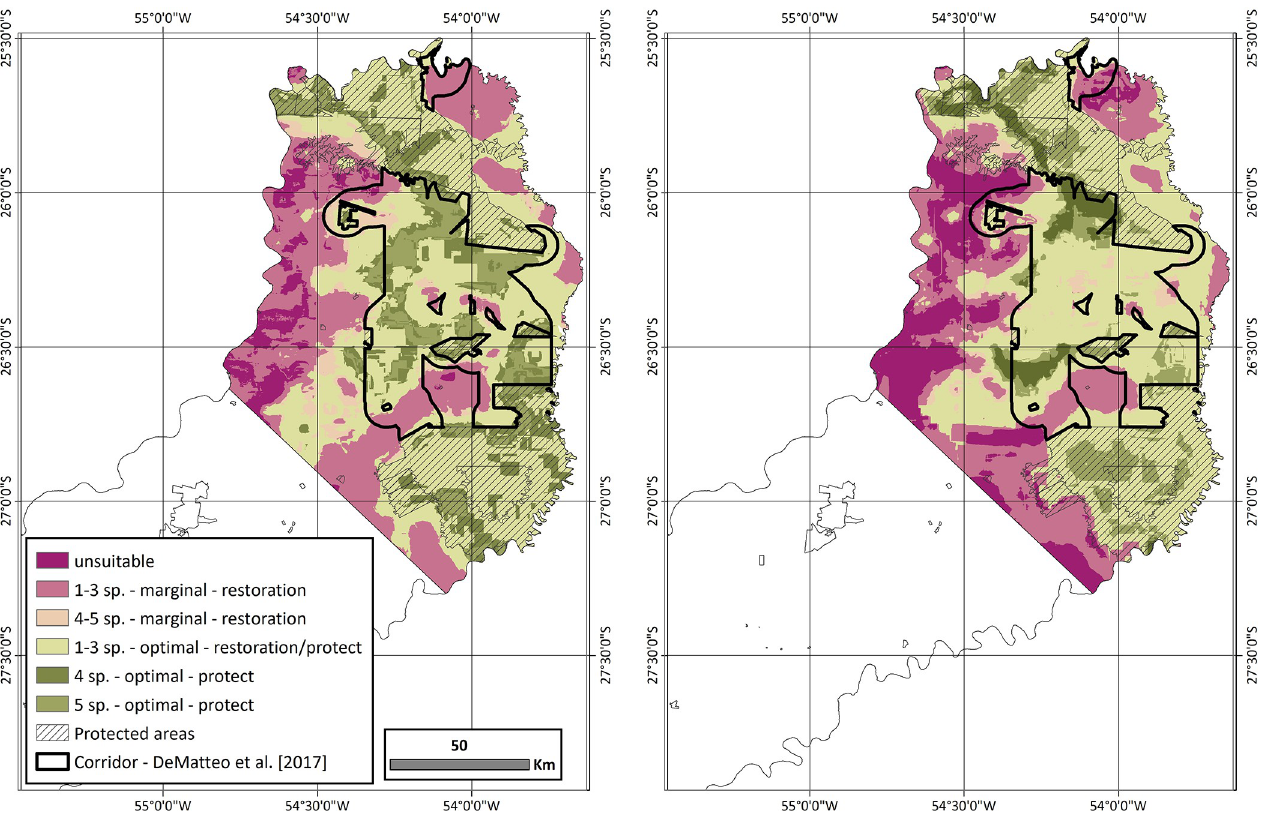
Fig 3. The potential species richness (PSR) represented as a summary of the proportion (%) of marginal and optimal habitat defined as suitable in the northern-central zone for Model 1 and Model 2. For each model, the overlap of marginal and optimal habitats was grouped into six classes: 0 species, 1–3 species with marginal habitat, 4–5 species with marginal habitat, 1–3 species with optimal habitat, 4 species with optimal habitat, and 5 species with optimal habitat. Each level is then categorized into the type of land management that is needed to optimized long-term survival of species in the corridor: Habitat restoration, habitat protection, or a combination of the two